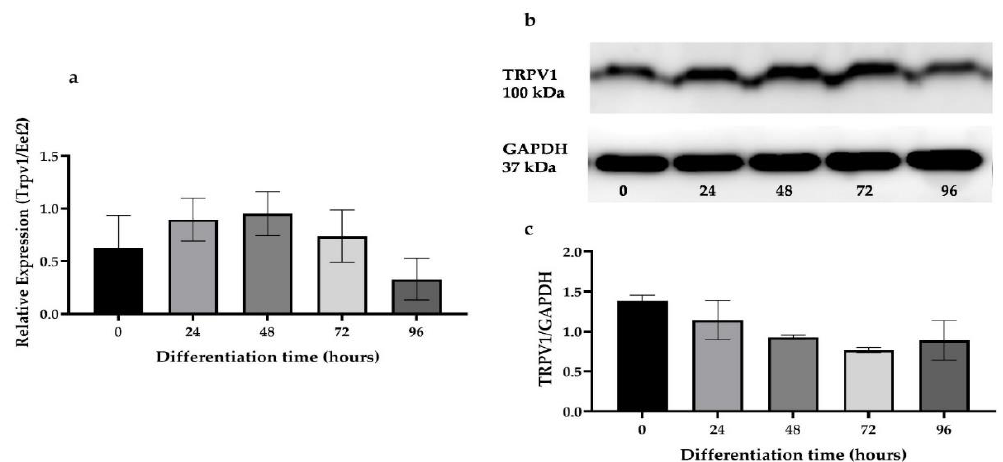
Figure 2. Expression of Trpv1 mRNA and protein levels during skeletal muscle cell differentiation. ( a ) Quantitative real-time PCR mRNA expression of Trpv1 during C2C12 skeletal muscle cell differentiation. ( b , c ) Western blot results and densitometric analysis of TRPV1 protein during the C2C12 differentiation, respectively. Data are presented as the mean ± SD of three independent repeats ( n = 3).